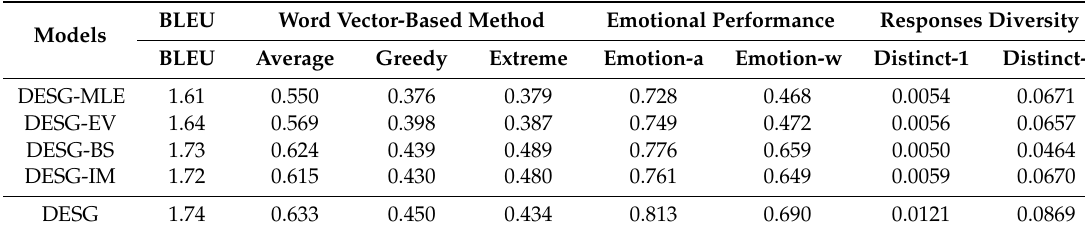
Table 5. Comparative results of ablation